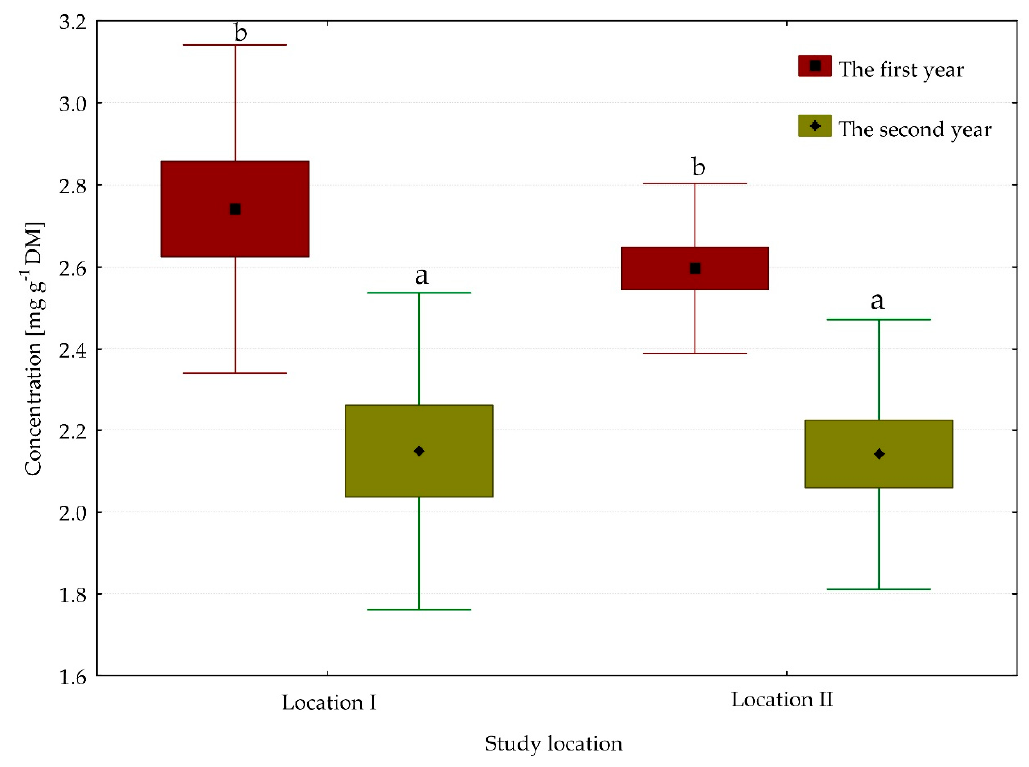
Figure 2. Chlorophyll b content in Melica nutans leaf blades from two natural forest stands.